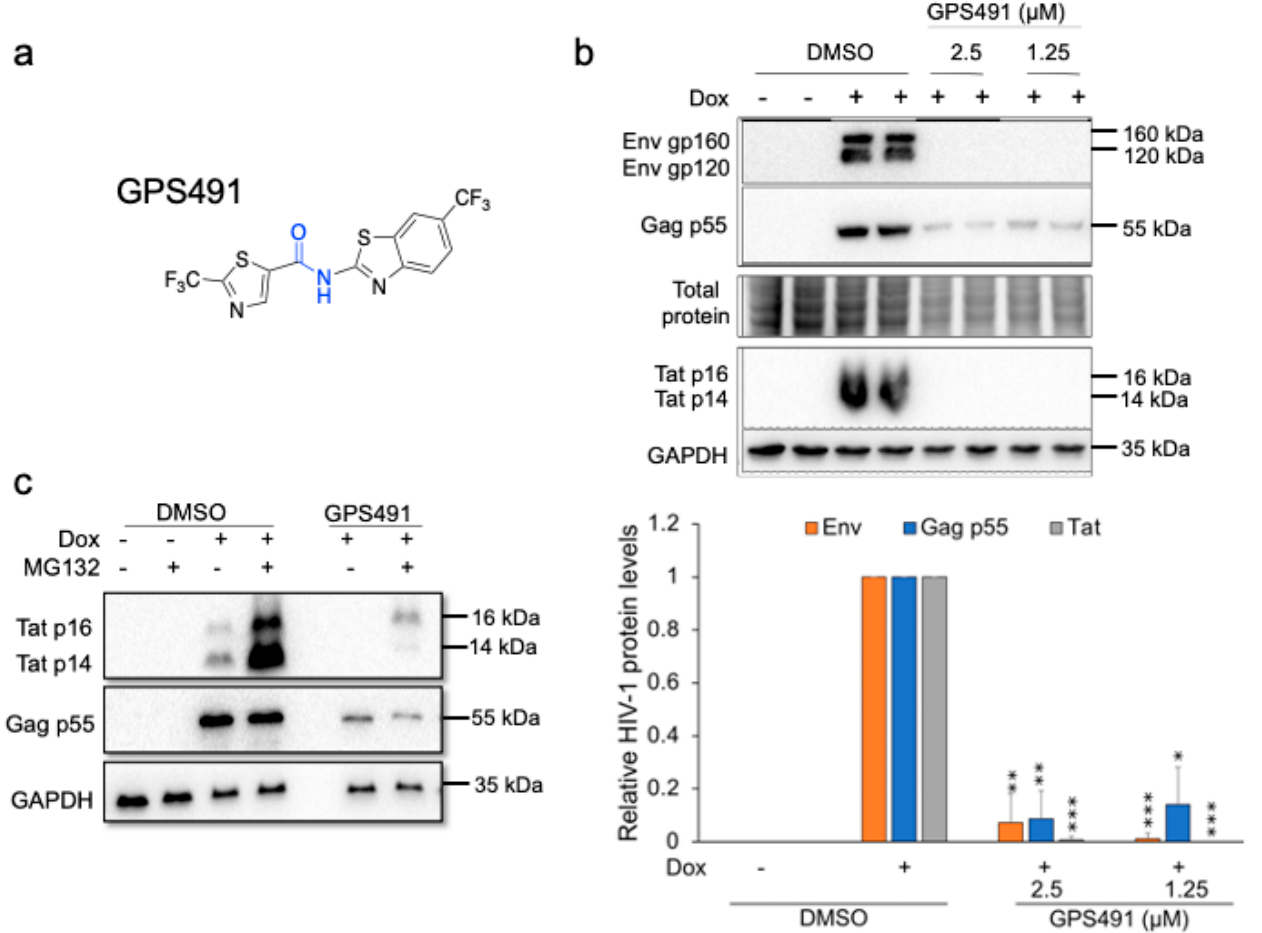
Figure 1. GPS491 inhibits expression of multiple HIV-1 proteins. ( a ) Chemical structure of GPS491. HeLa rtTA HIV ∆ mls cells were treated with either 2.5 µM or 1.25 µM GPS491. Cells grown with or without doxycycline (Dox) with 1% DMSO served as positive and negative controls, respectively. Cells were harvested for HIV-1 protein and RNA analyses after 24 h of induction. ( b ) Shown are representative Western blots showing the effects of compounds on HIV-1 Gag, Env, and Tat levels. Below is a summary of n = 3 independent experiments; data are indicated as mean ± SD; * p ≤ 0.05, ** p ≤ 0.01, and *** p ≤ 0.001. ( c ) Proteasome inhibition reverses the effect of GPS491 on Tat but not Gag expression. HeLa rtTA HIV ∆ mls cells were treated with DMSO or GPS491 +/ − Dox for 24 h. Cells were treated with or without MG132 8 h prior to harvest, lysates were fractionated on 10% stain-free gels or 14% SDS PAGE gels, and the resulting blots were probed for HIV-1 Gag or Tat, respectively. Band intensity was quantified relative to Dox-induced DMSO control and normalized to total protein load (Stainfree) for Gag blot or normalized to GAPDH for Tat blot using Bio-Rad ImageLab